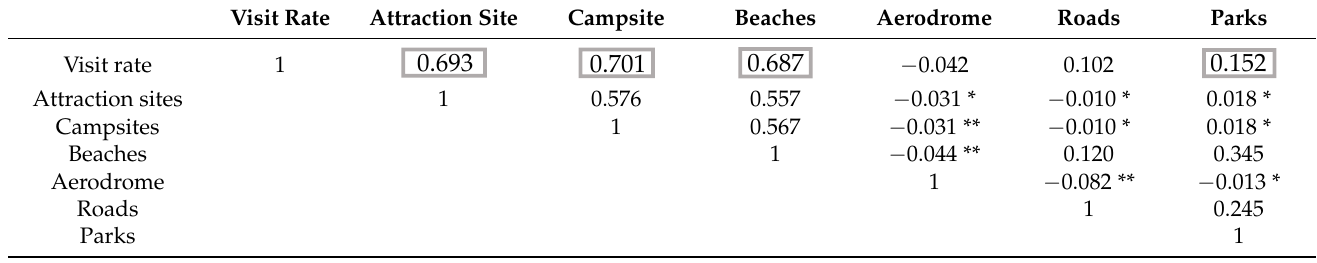
Table 2. Pearson’s correlation quantifying the relationship between the visit rates and landscape features (* p < 0.05 and ** p < 0.01). Gray shading indicates strong positive correlations ( p ≥ 0.15).